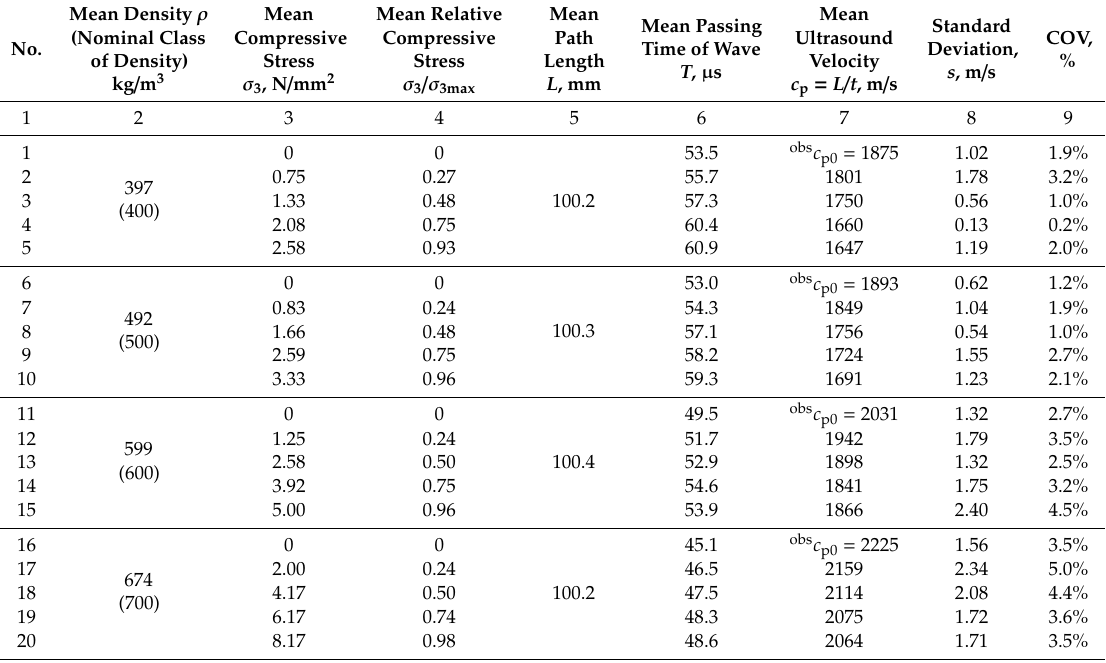
Table 2. Test results for ultrasound velocity in AAC at various compressive